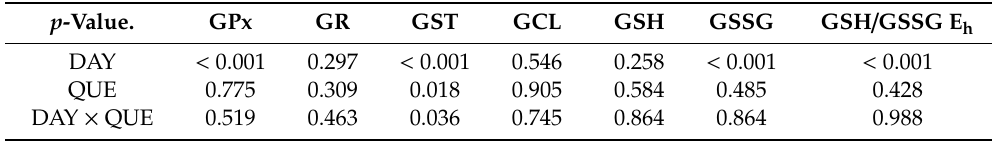
Table 7. Significance levels for treatment e ff ects on the glutathione redox system in lever tissue of piglets at d5 and d14post-weaning (DAY), fed a diet containing 0, 100, 300, or 900 mg quercetin / kg diet (QUE) during the first 14d post-weaning ( n = 8).